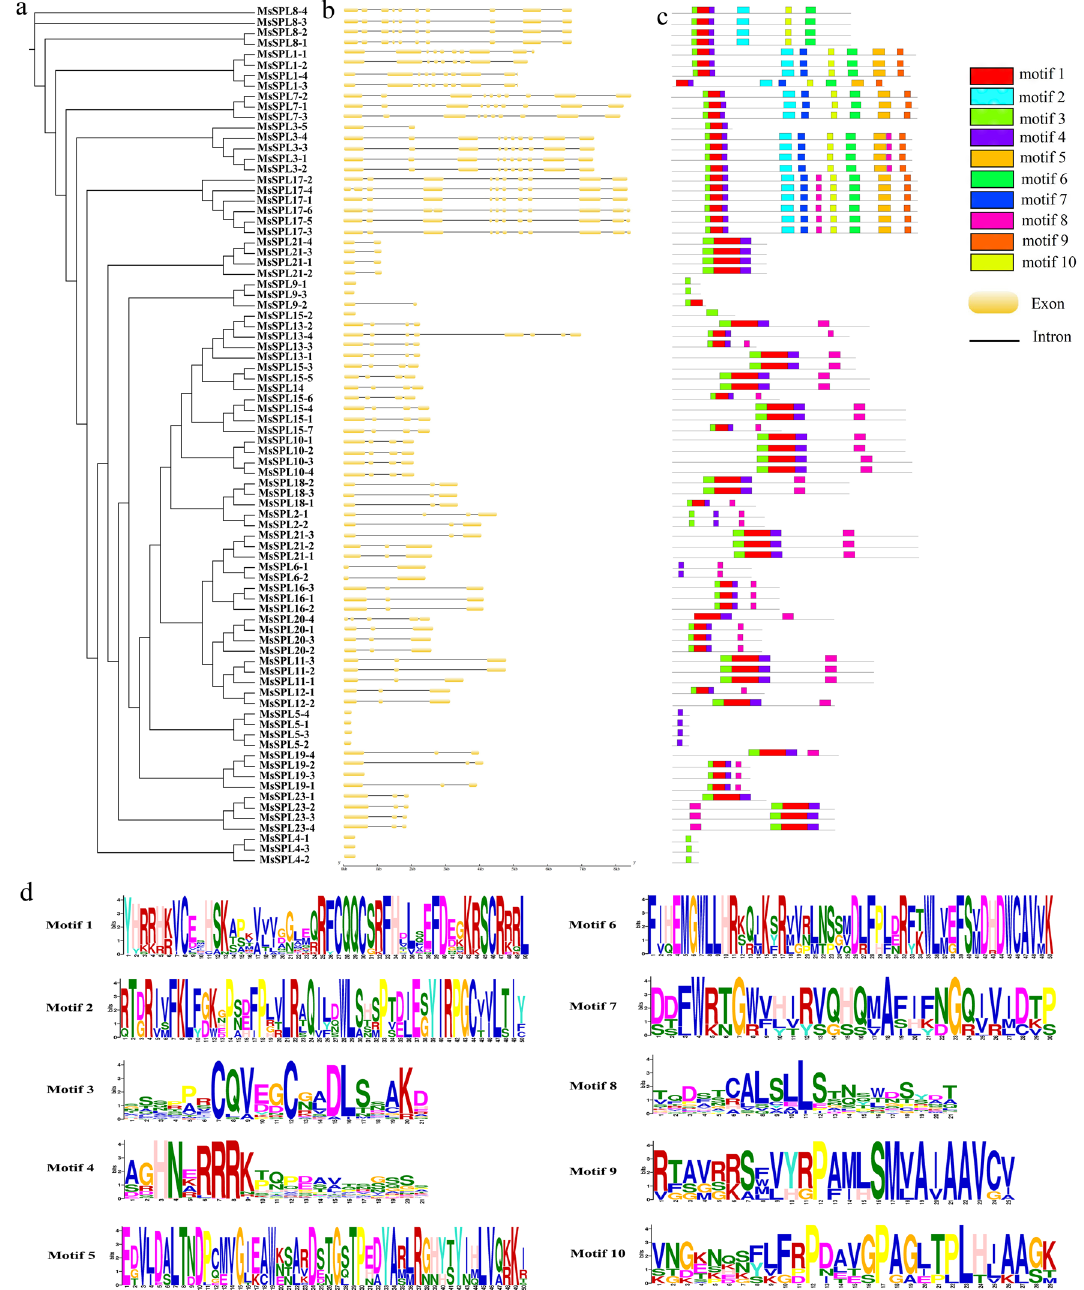
Figure 3. Gene structure and conserved motif analysis. ( a ) Alfalfa SPL evolutionary tree; ( b ) exon-intron structure of the SPL genes in alfalfa, the yellow box represents the exon, and the black line connecting the two exons represents the intron; ( c ) the conserved motif in alfalfa, each motif is shown as a box in one of 10 different colors; ( d ) ten conserved motif conserved motifs (named motif 1-10) were identified (Fig. 3d), and the conserved motifs of members of the same subfamily were similar, the subfamily with the largest number of exons also contained the most motifs (Fig. 3c). 88% (72) genes of the 82 alleles and paralogs contained multiple motif structures, and 12% (10) genes contained only one motif structure, among which motif 1, motif 3, motif 4, and motif 8 were the most conserved and shared by most MsSPL proteins. In addition to common motifs, each group of motifs also has certain specificity, and there are similar conserved motifs among subfamilies, such as motif 2, motif 6, and motif 10, which are only found in I subgroup. The presence of subfamily-specific conserved motifs in the subfamily may play an critical role in the functional specificity of the subfamilies.